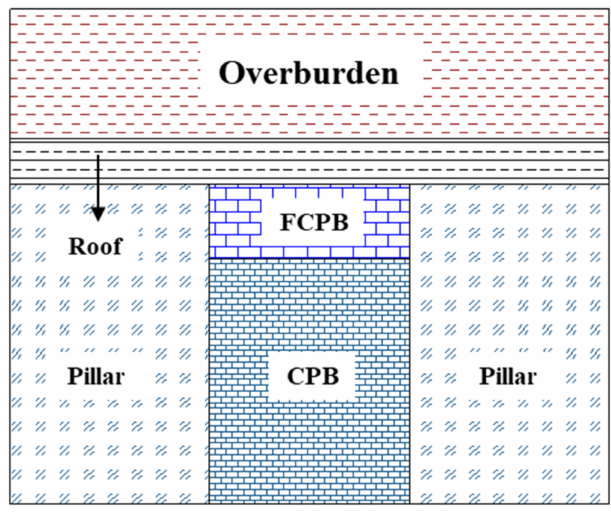
Figure 1. The application design of FCPB in mining (adapted from Ref.